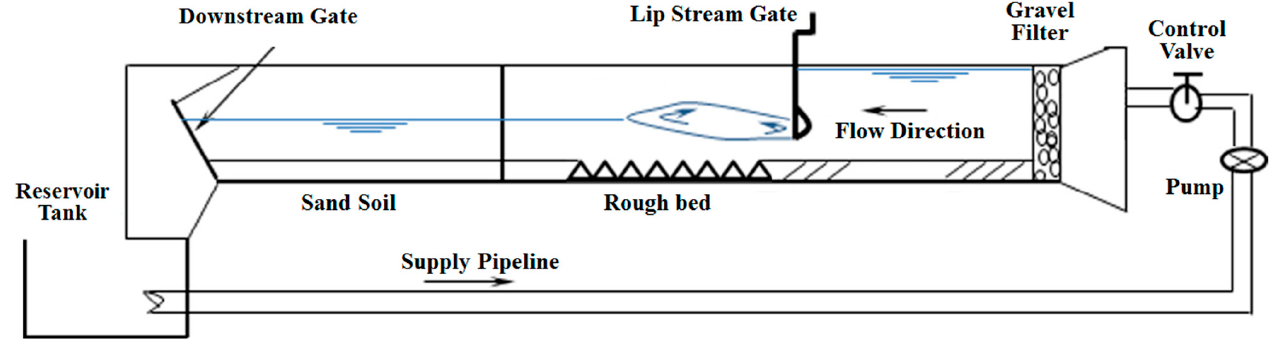
Figure 2. Longitudinal profile of the experimental flume (Ahmed et al. [20]).